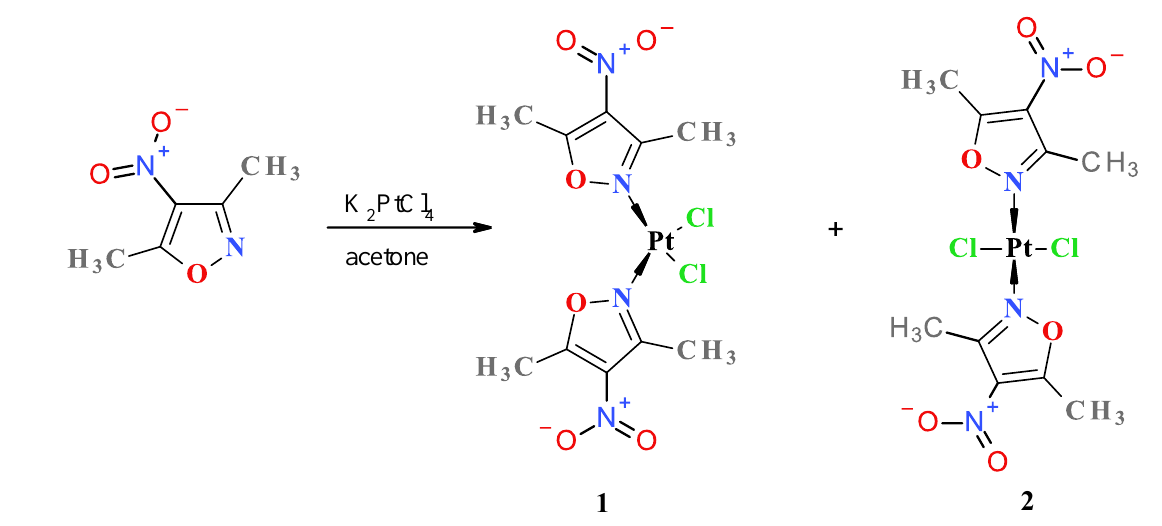
Figure 1. Scheme of synthesis of platinum(II) complexes 1 and 2 .